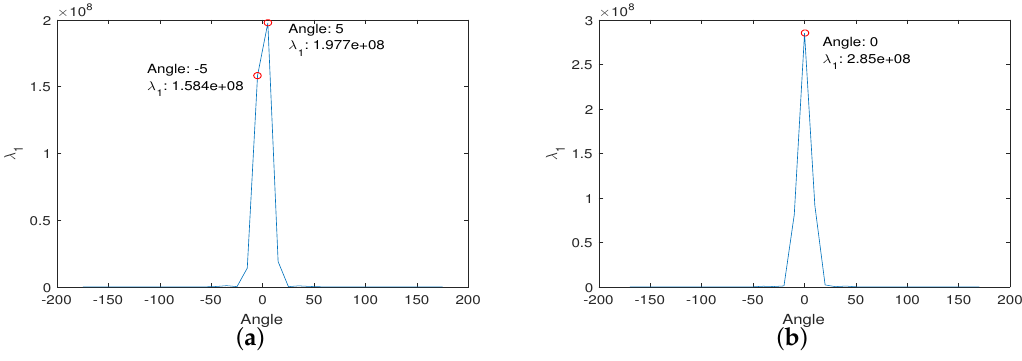
Figure 11. λ 1 of the dihedral, with sub-aperture starting from: ( a ) − 180 ◦ ; and ( b ) − 175 ◦